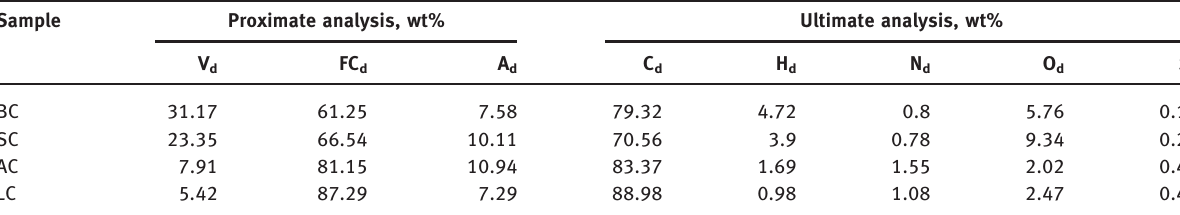
Table 1: Proximate and ultimate analysis of different samples.